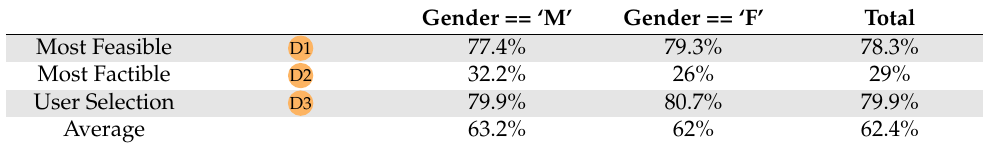
Table 3. Impact analysis of certain counterfactuals, suggested by the tool and selected by the expert. Gender == ‘M’ Gender == ‘F’ Total Most Feasible D1 77.4% 79.3% 78.3% Most Factible D2 32.2% 26% 29% User Selection D3 79.9% 80.7% 79.9% Average 63.2% 62%